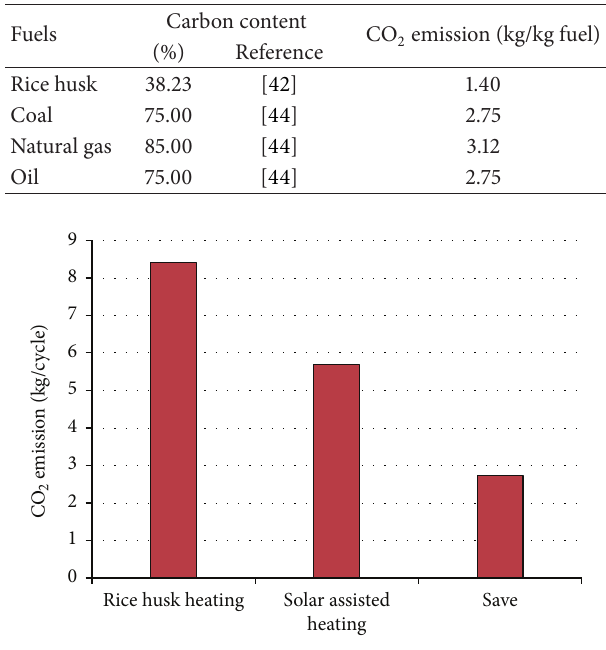
Table 4: Amount of CO